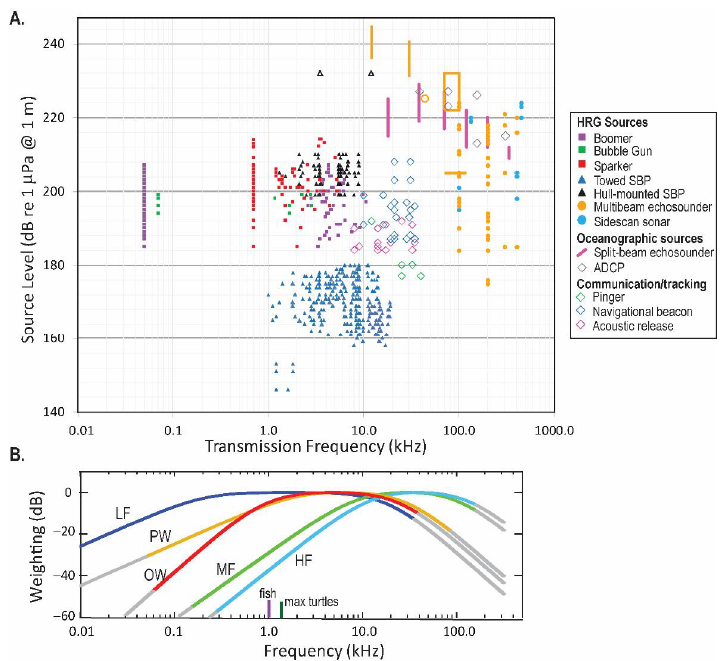
Figure 4. ( A ) SL for non-airgun sources considered in this paper. High-resolution geophysical (HRG) sources are coded as squares for seismic sources, triangles for non-parametric subbottom profilers (SBP), and circles for sonar-based sources. Solid symbols plotted as point data for HRG sources show values measured by [8]. Open symbols denote data compiled from manufacturers’ specifications [23,57–59] for ADCPs, pingers, navigational beacons, and acoustic releases. SL for hull-mounted SBP shown as open symbols are calculated in this paper. The data shown as lines for multibeam echosounders and split-beam echosounders are from manufacturer’s specifications and other studies [23,42,57,58]. Navigational beacons refer only to USBL sources. ( B ) The curves show auditory weighting functions for marine mammal hearing groups, as derived from composite audiograms in [18]. The colored portion of each curve coincides with the generalized hearing range for each marine mammal group: Low-frequency cetaceans (LF), mid-frequency cetaceans (MF), high- frequency cetaceans (HF), phocids in water (PW), and otariids in water (OW). Less negative weighting corresponds to the range of greatest hearing sensitivity for that group of mammals. The purple line represents the upper limit of hearing for the majority of fish species that have been tested [60]. The green line is the upper hearing frequency for sea turtles, including juveniles studied by